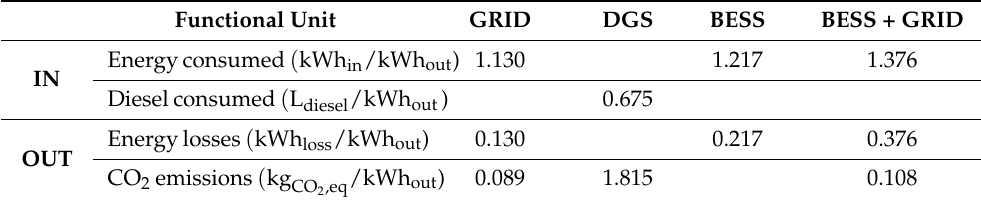
Table 8. LCI of each functional unit (columns) including all inputs/outputs (rows). Functional Unit GRID DGS BESS BESS + GRID Energy consumed ( kWh in /kWh out ) 1.130 1.217 IN Energy losses ( kWh loss /kWh out OUT